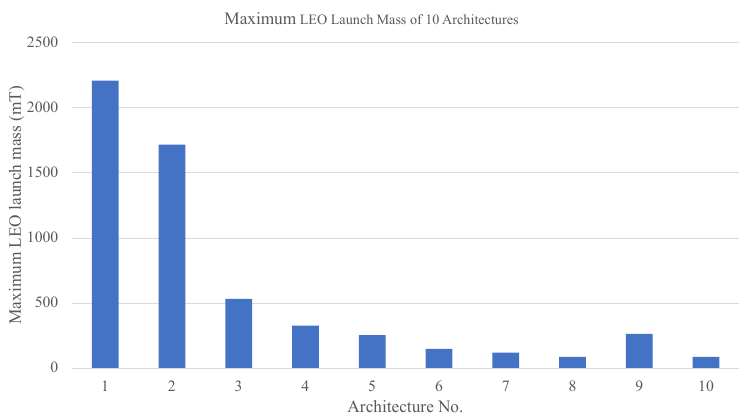
Figure 17. Total mass scale of 10 different architecture.